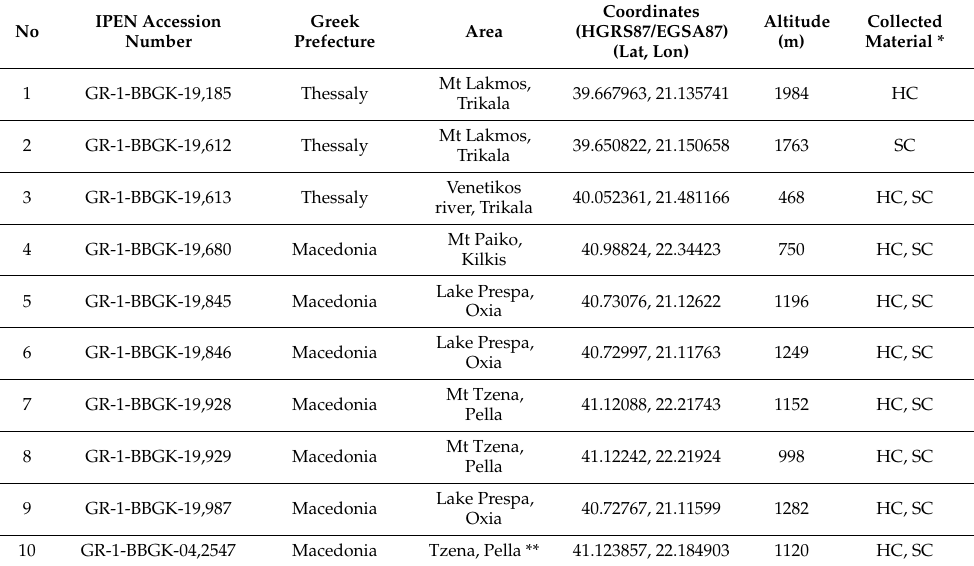
Table 3. IPEN (International Plant Exchange Network) accession numbers assigned to the collected samples of Greek native Amelanchier ovalis wild-growing populations, with collection details and the types of material collected.